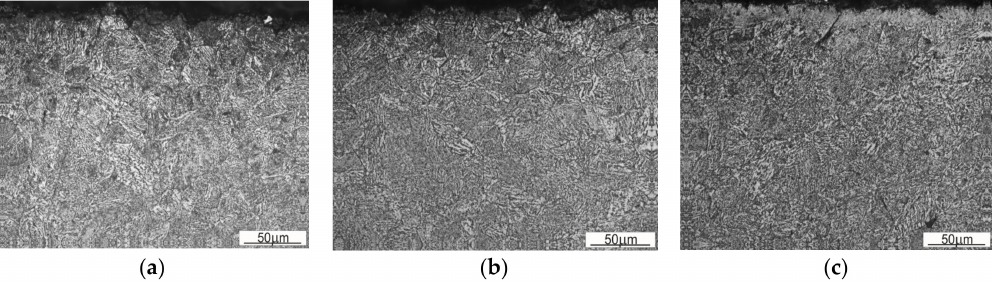
Figure 15. Microstructure within the edge area of the sample from the fifth row. ( a ) Side A; ( b ) Edge AB; ( c ) Side